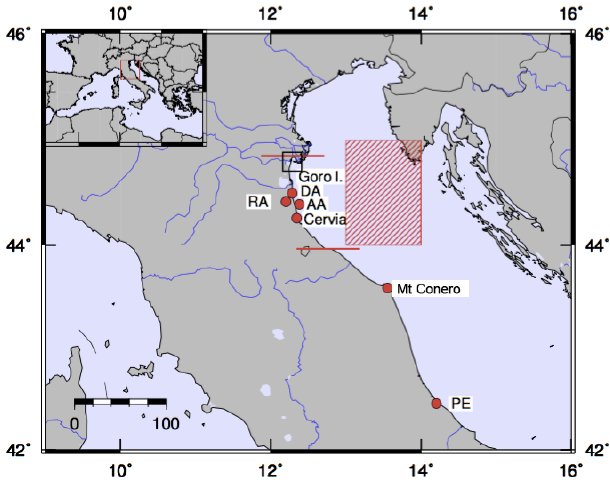
Figure 1. Map of the northern Adriatic Sea and of the surroundings. Horizontal ticks on the east coast of Italy mark the northern and southern limits of the E-R shoreline. The hatched rectangle shows the cell of the IPCC AR5 discretisation of the global oceans used to represent the projected sea-level change in front of the E-R coast (RA: Ravenna, AA: Angela–Angelina gas field, PE: Pescara). The town of Cervia divides the E-R coast into two sectors, referenced as north (N) and south (S) in the body of the paper. DA: Dosso degli Angeli gas field; Goro l.: Goro